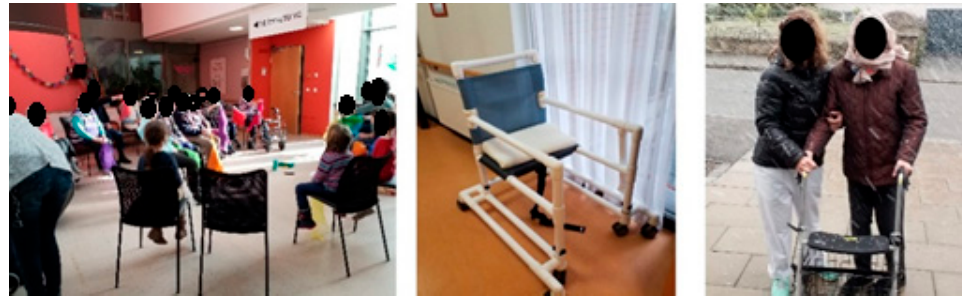
Figure 4. Differences in photographs taken, 1. residents, 2. staff, 3. significant others. Photographs taken by significant others either featured professional services (in the case of physiotherapists or priests) or documented infrastructural or architectural issues. No photographs were taken of staff performing mobilizing